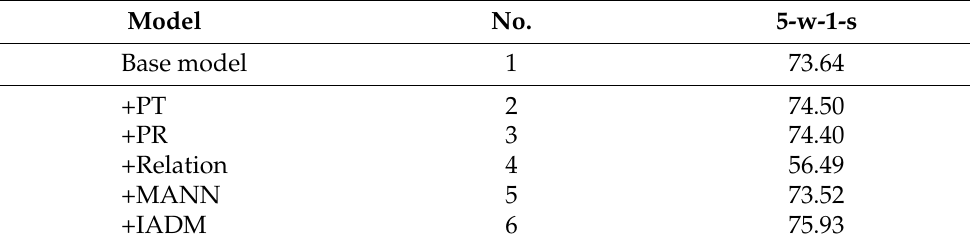
Table 5. Class predictor comparison, Model is the abbreviation for proposed model name and No. is their identification number (the same below). PT represents power transforms, PR represents prototype rectification, Relation represents the relation network for few-shot learning, MANN represents the memory aggregated neural network, and IADM represents the input-adaptive distance metric from the MCT